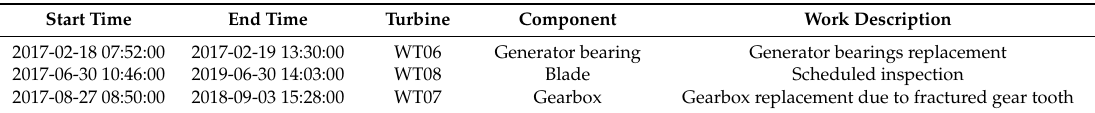
Table 3. Work order